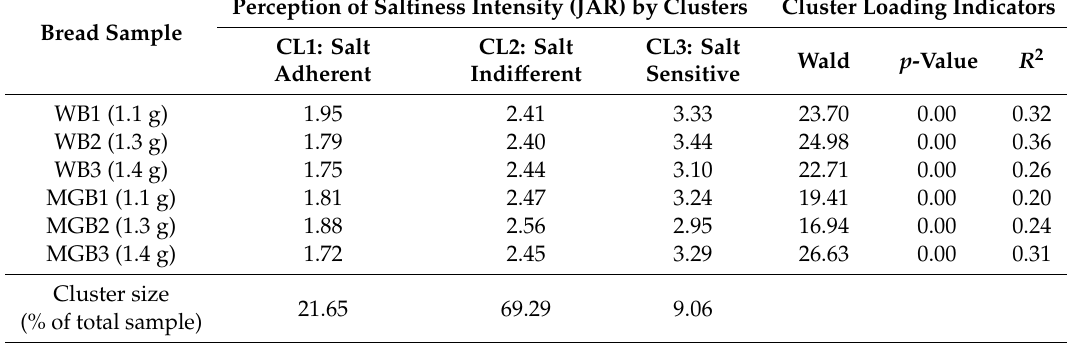
Table 5. Cluster sizes, class-specific marginal means and parameter estimates for the perception of saltiness intensity in breads (5-point JAR) ( n = 200). Bread Sample